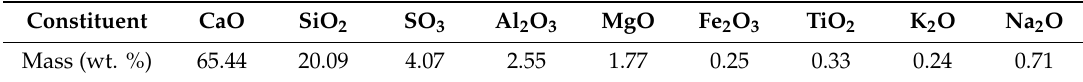
Table 1. Major chemical compositions of withe Portland cement.